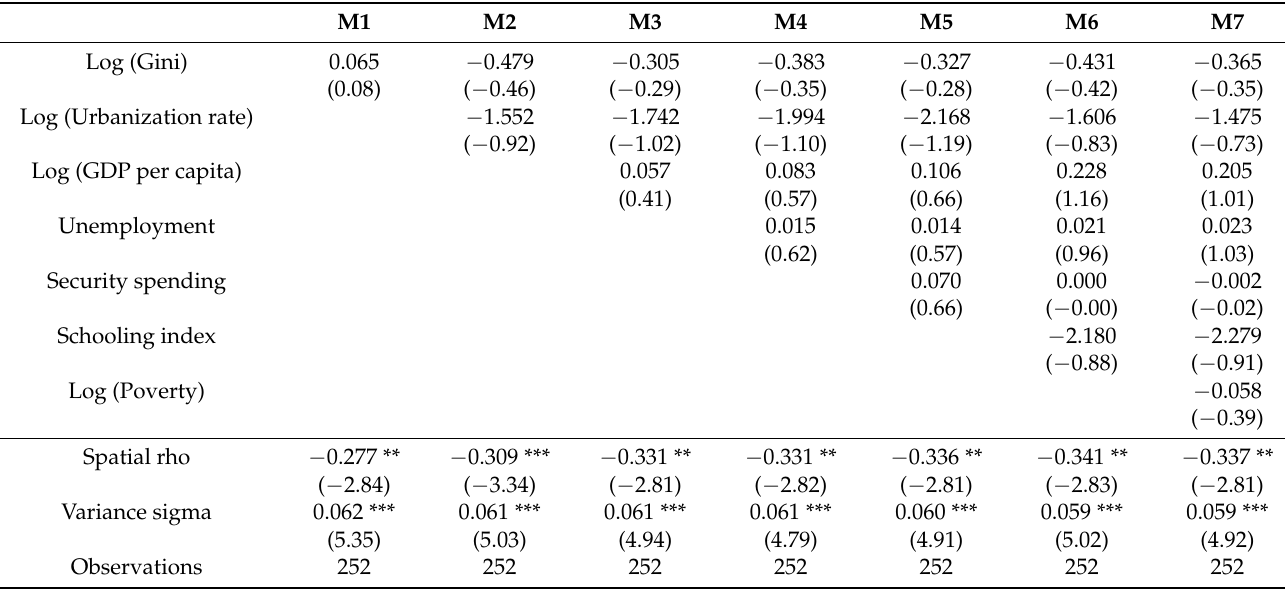
Table 9. Results of the SAR spatial model, of the relationship between inequality and the homicide rate, including the control